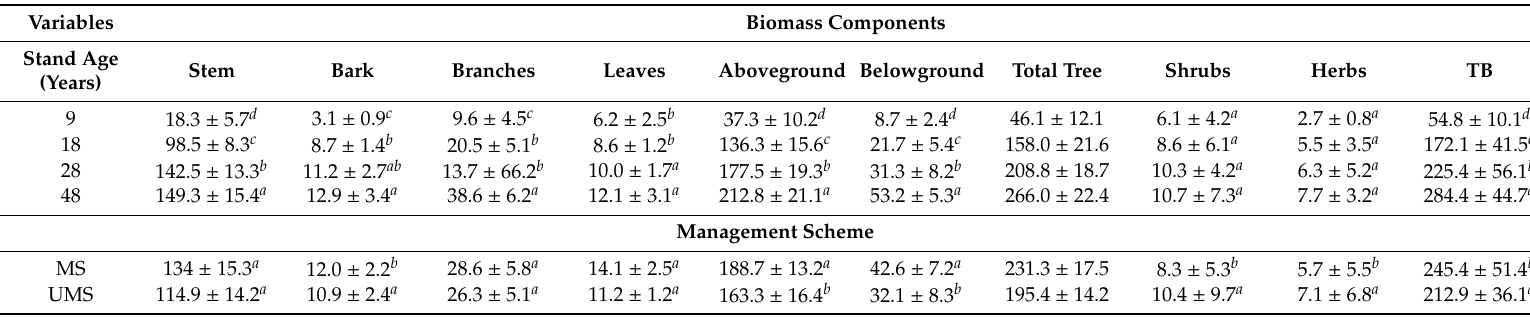
Table 1. Biomass (Mg ha − 1 ) in tree and forest floor vegetation, in 9, 18, 28, and 48 year age groups and the two management treatments of Masson pine ( Pinus massoniana Lamb) in the Taizishan Forestry Administration Bureau. Data are means ± SD of each component in the sampled forest stands. Means within columns followed by di ff erent lower-case letters were significantly di ff erent ( p = 0.05) as per ANOVA followed by the LSD test. (TB = total